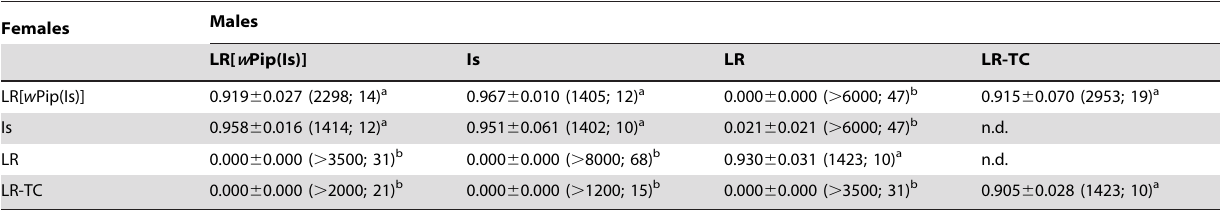
Table 2. Comparisons of CI properties of different mosquito lines.